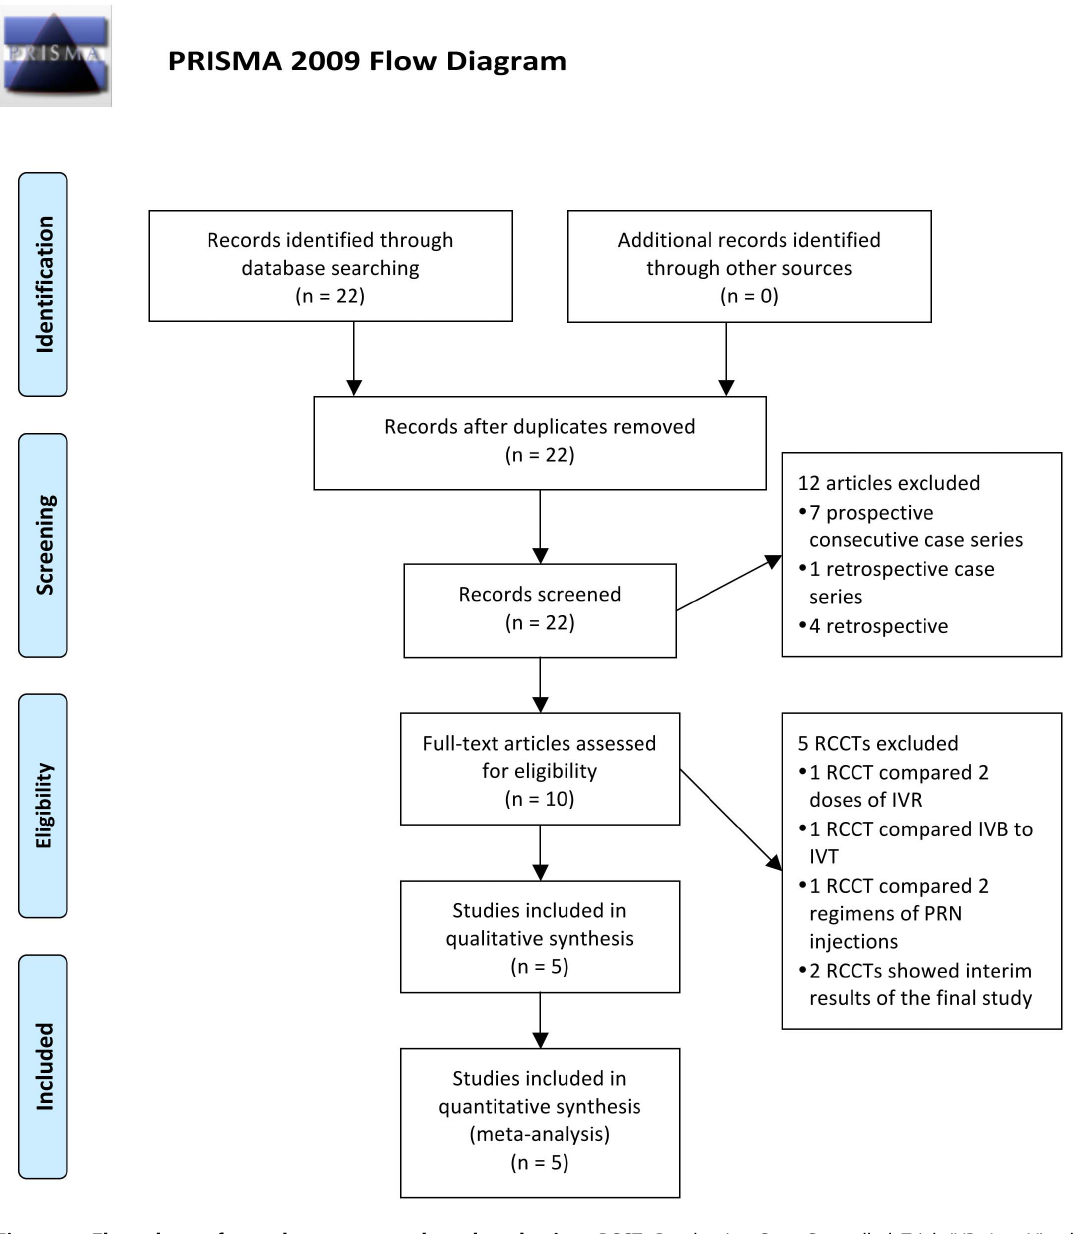
Figure 1. Flow chart of search strategy and study selection. RCCT: Randomize Case Controlled Trial, IVR: IntraViteal Ranibizumab, IVB: IntraViteal Bevacizumab, IVT: IntraViteal Triamcinolone acetonide (IVT), PRN: Pro Re Nata.